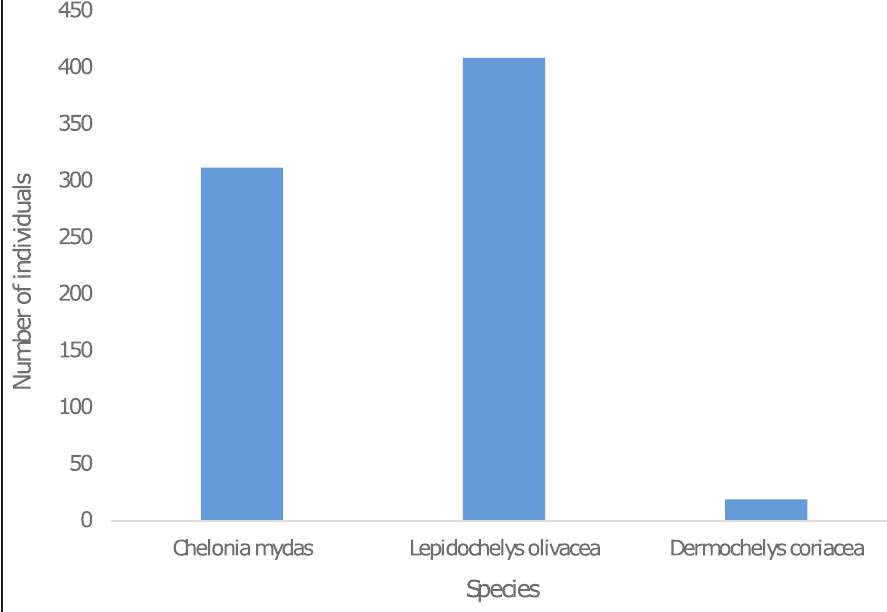
19 of Leatherback turtle ( Dermochelys coriacea (Vandelli, 1761)) (Figure 5c). Figure 3 shows the distribution of these turtle on the Togolese coast. This distribution is more or less extensive depending on the collection locations (Figure 4).